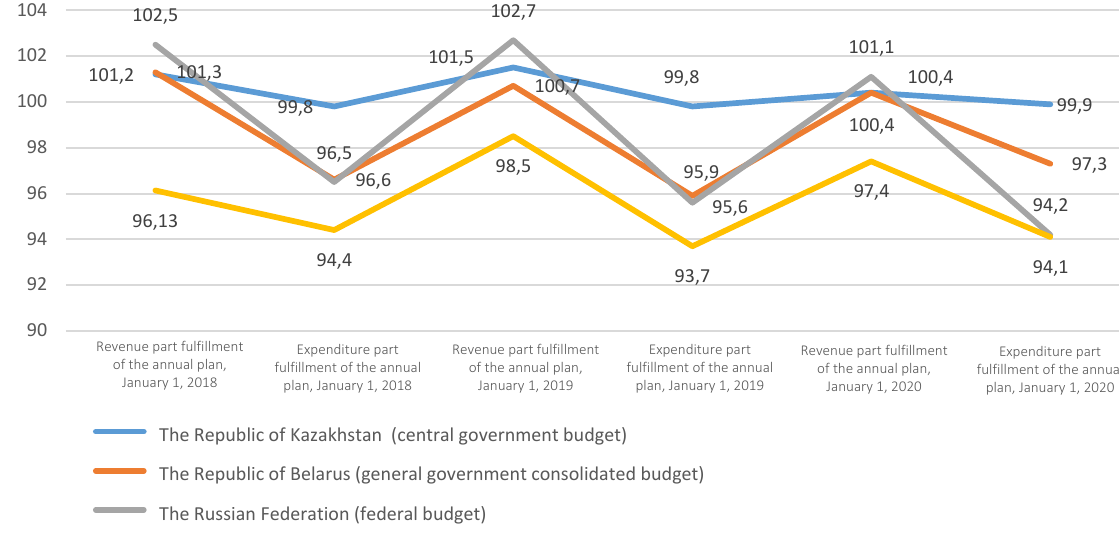
Figure 1. Execution of revenue and expenditure parts of budgets,